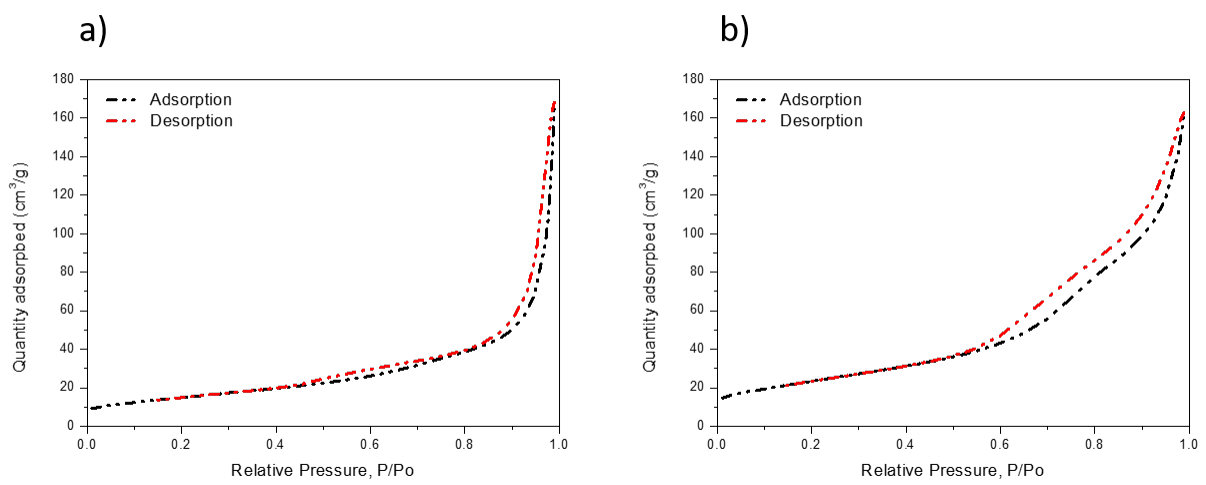
Figure 5. N 2 adsorption-desorption isotherms of ( a ) P25 and ( b ) TiO 2 hollow nanospheres.